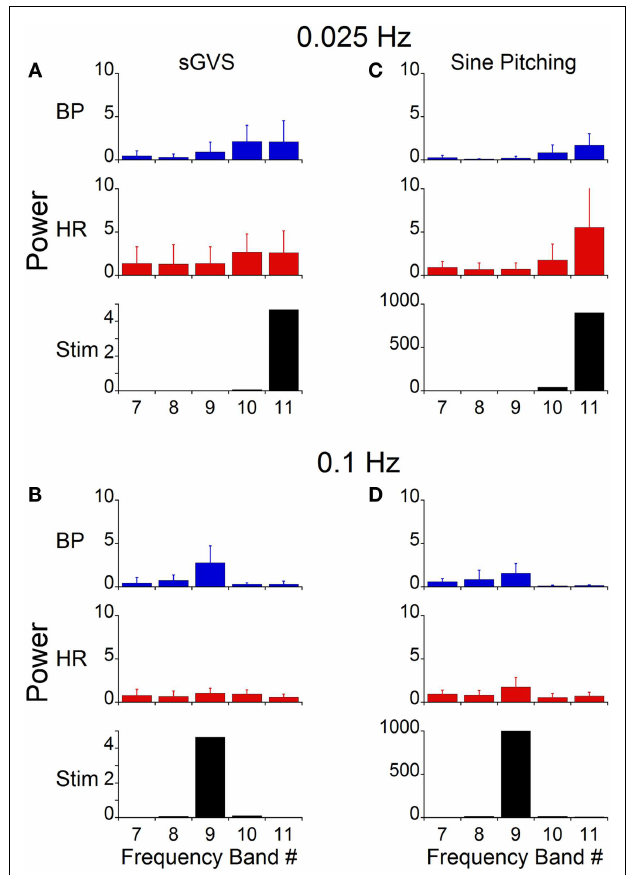
FIGURE 7 | Power of BP, HR, and stimulus of vasovagal oscillation in different frequency bands induced by sGVS and sinusoidal pitching ± 70° .The data were obtained at 0.025Hz (A,C) and 0.1Hz (B,D) .The stimulus power was in a single band [band 11 in (A,C) ; band 9 in (B,D) ]. Most of the power in BP and HR was at the stimulus and at twice the stimulus frequencies.The error bars represent one